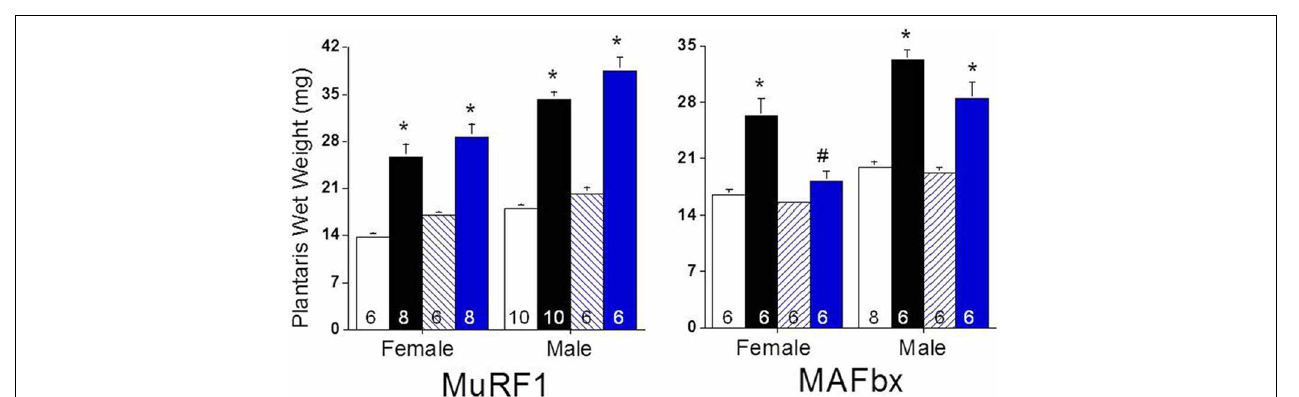
( n = 7/group) ∗ P < 0 . 05 vs. control mRNA expression. Activity of the β 5 subunit of the 20S (D) and 26S (E) proteasome was assessed by fluorometric assay in WT mice following no treatment (Con) and FO for 1, 3, 7, or 14 days. Data is expressed as a percentage of the control value (mean ± SD , n = 5–8/group). ∗ P < 0 . 05 vs. control proteolytic activity.